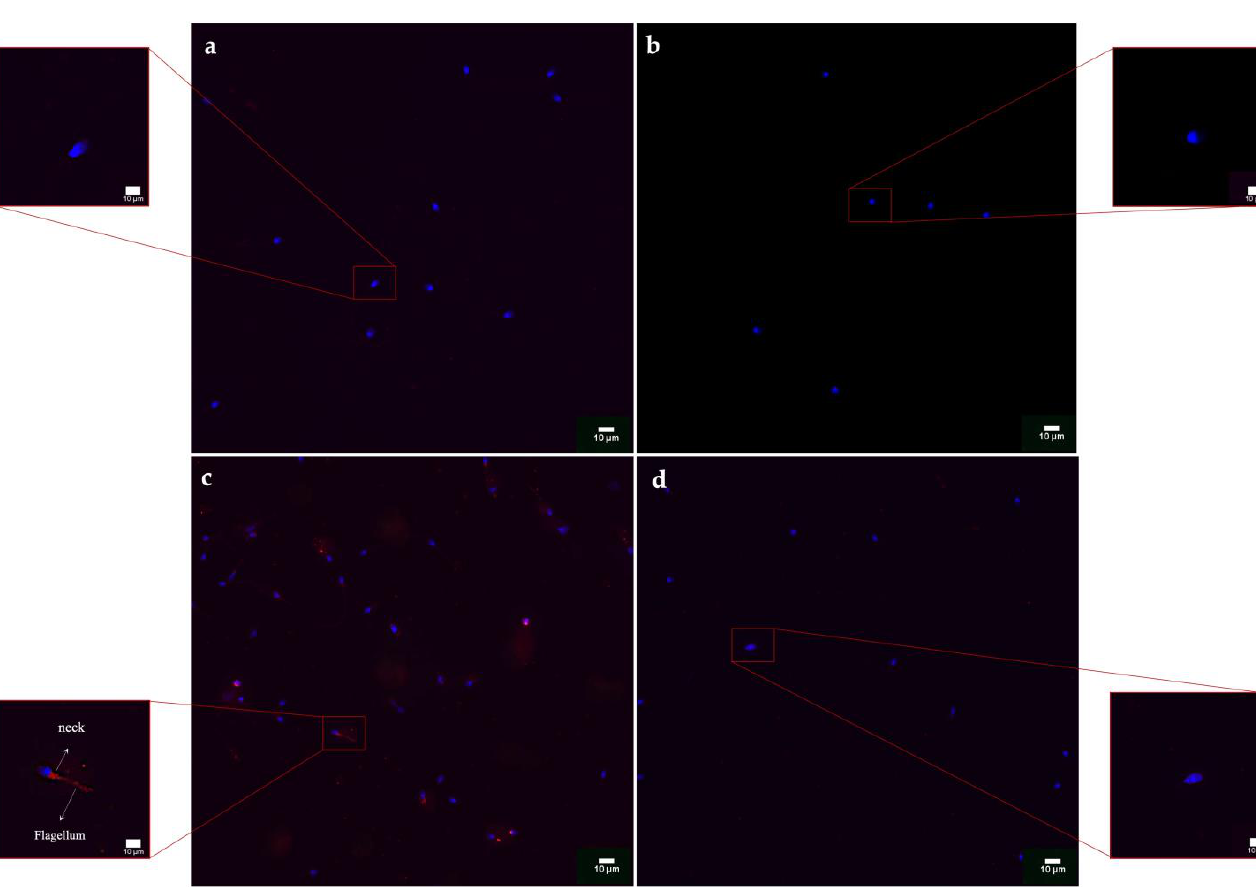
Figure 10. Correlation analysis: ( a ) relation between HSP70 expression and DNA fragmentation; ( b ) relation between HSP70 expression and oxidative stress; ( c ) relation between HSP70 expression and mitochondrial disfunction.